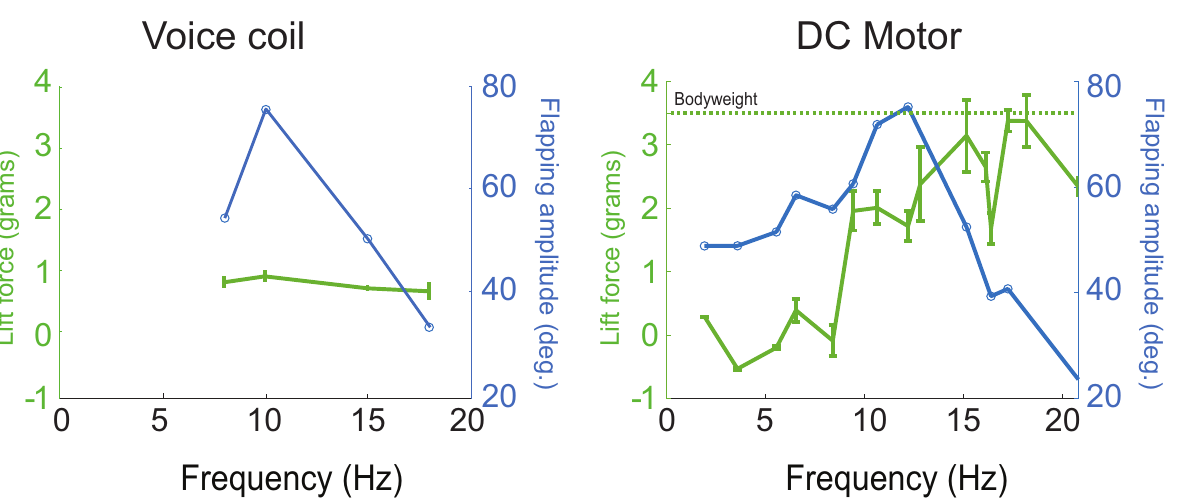
Figure 9. Lift force and flapping amplitude vs. frequency for the voice coil-driven robot and the rotary motor-driven robot. Both show a resonant peak characteristic of elastic energy exchange, but the rotary motor produces significantly higher lift. The dashed green line indicates the weight support lift threshold.